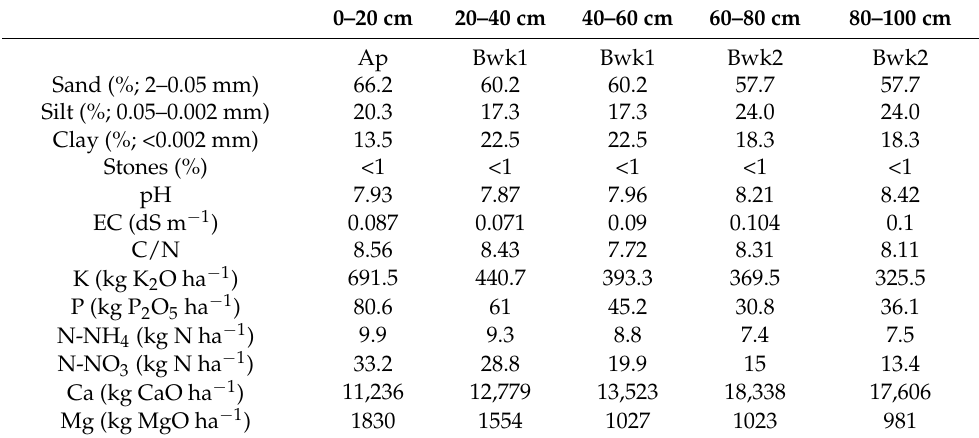
Table 1. Soil physical-chemical properties at the beginning of the